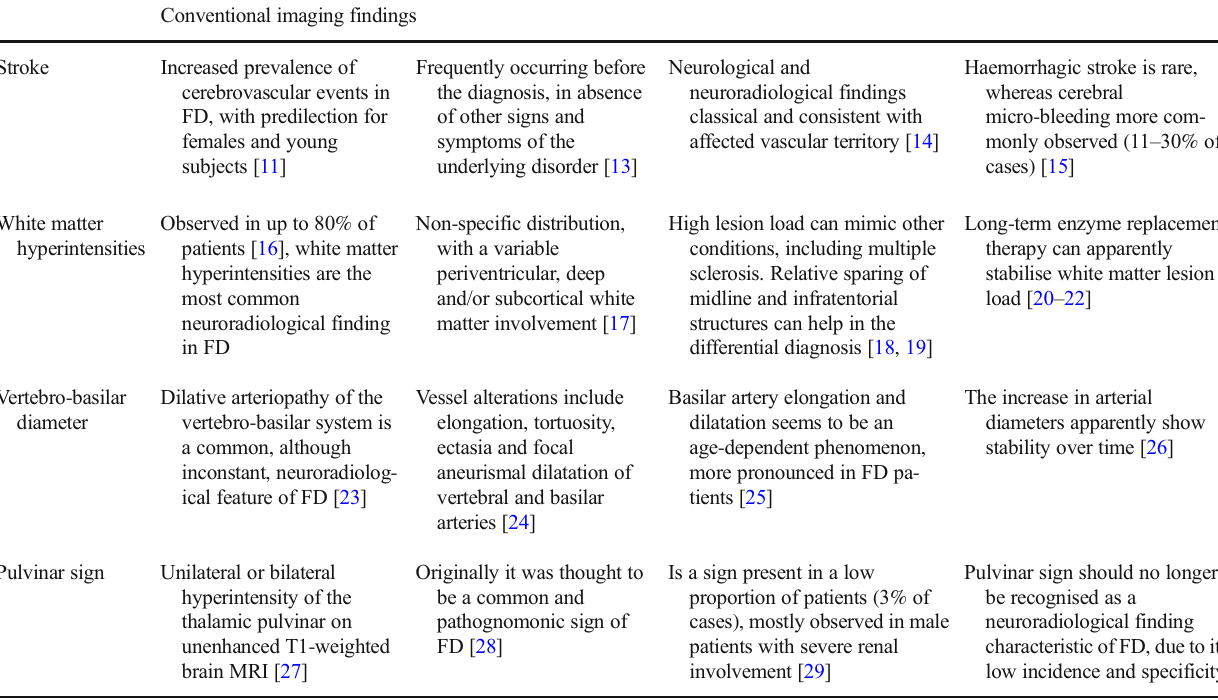
The major conventional imaging findings in Fabry disease Conventional imaging